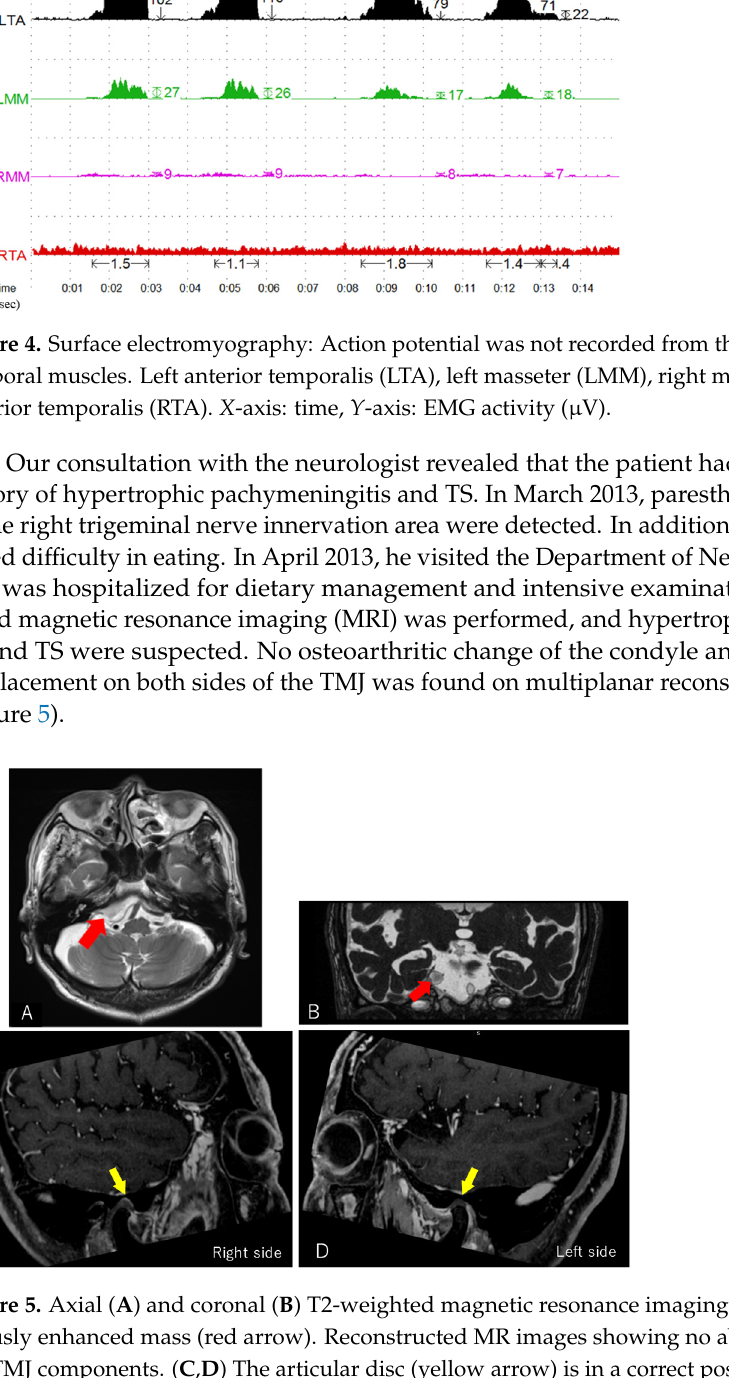
Figure 3. Axial contrast-enhanced computed tomography (CT) of the soft tissue ( A , B ) and coronal CT of the head ( C ). Atrophy of the right masseter muscle, lateral and medial pterygoid muscles, and temporalis muscle (red arrow) compared with the contralateral side.